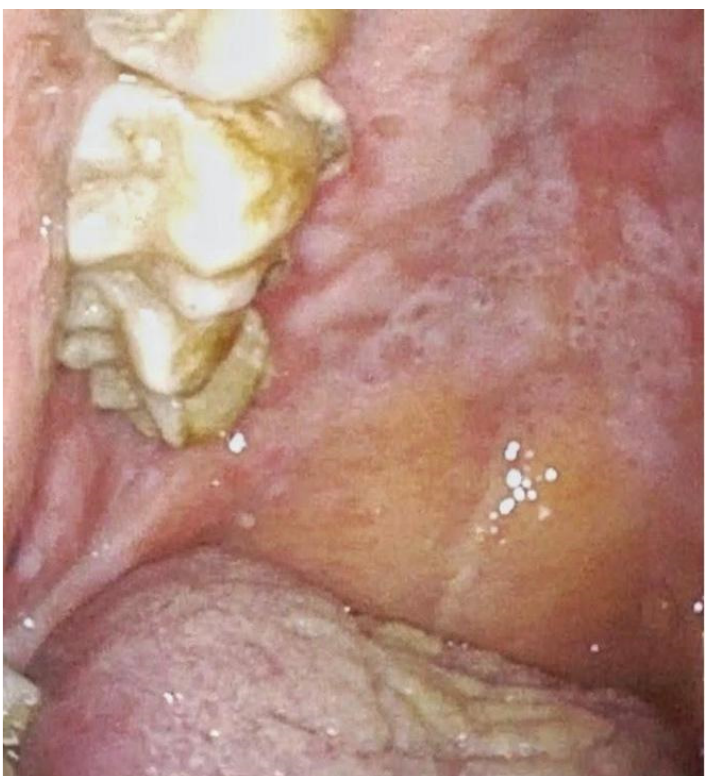
Figure 2. Leucoplakia of the hard palate with erosive spots and erythematous mucosa.